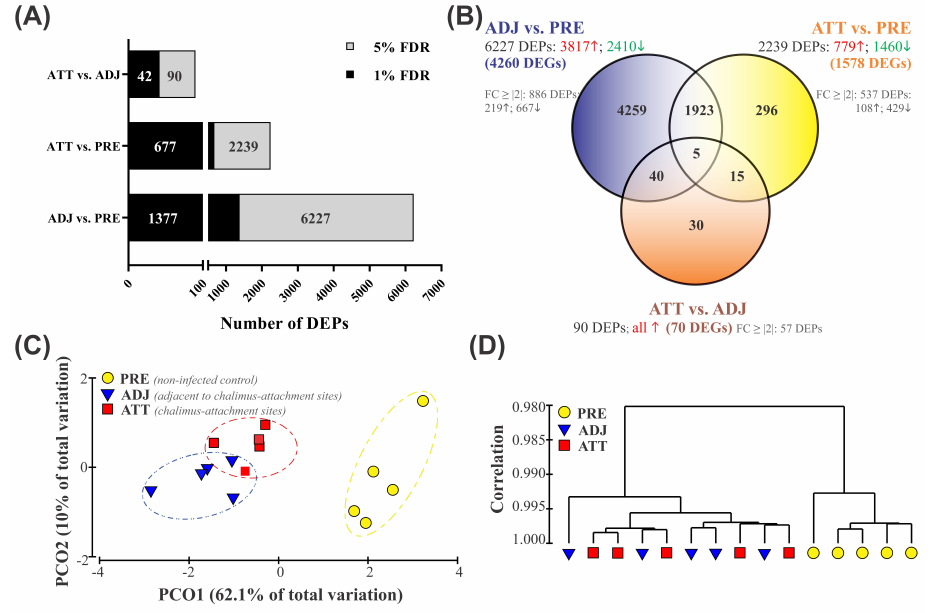
Figure 1. Overview of resulting global transcript expression profiles. ( A ) The global profile of di ff erentially expressed probes (DEPs) identified by the Significance Analysis of Microarrays (SAM) algorithm using a modified t -test. Grey and black color bars (and the numbers on them) indicate the number of DEPs at false discovery rates (FDRs) of 5% and 1%, respectively. ( B ) Venn diagram showing the distribution of 6568 DEPs among three di ff erent comparisons of lice infection treatments. Numbers in red ( ↑ ) and green ( ↓ ) indicate up- and down-regulated DEPs, respectively. FC ≥ # indicates the number of DEPs with a fold-change value ≥ | 2 | . Detailed profiles of DEPs are available in Supplementary Files S1 and S2. ( C , D ) Principal coordinate analysis (PCoA) and hierarchical clustering analysis of fin samples from control (PRE) and sea lice-infected (ADJ and ATT) fish based on the expression dataset of DEPs ( n = 6568). ( C ) PCoA of a resemblance matrix generated using Bray-Curtis similarity coe ffi cients. ( D ) Complete linkage clustering was performed using Pearson correlation in the